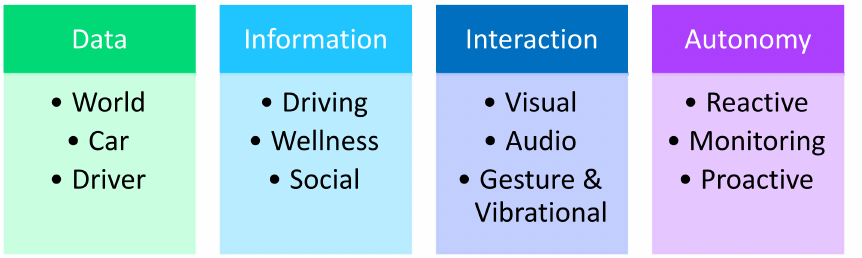
Figure 1. The smart driving interface